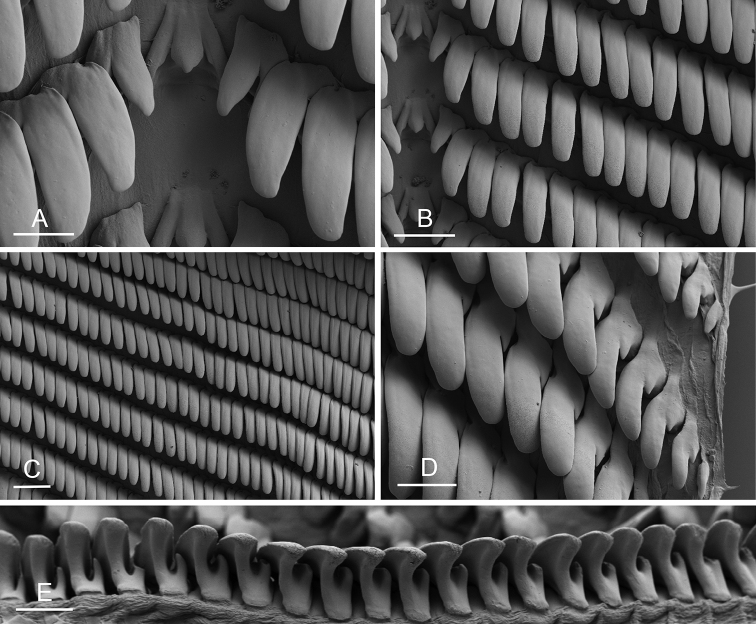
Radula, Peronia
verruculata (unit #2), Indonesia, Sumatra A–D [1795] (UMIZ 00180) E [1746] (UMIZ 00178) A rachidian and innermost lateral teeth B rachidian and innermost lateral teeth C lateral teeth D outermost lateral teeth E lateral teeth, frontal view. Scale bars: 40 μm (A, D), 80 μm (B), 100 μm (C), 60 μm (E).